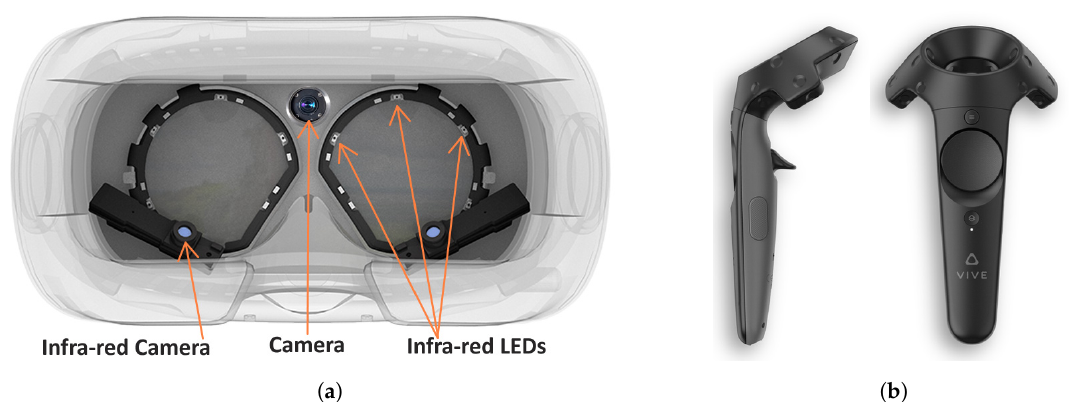
Figure 4. ( a ) The HMD upgraded for Gaze tracking: Interior view of a HMD device fitted with eye tracking hardware. ( b ) VR Hand-Held Controller (HHC) used in our study by participants to interact with VR objects with 6-DOF.